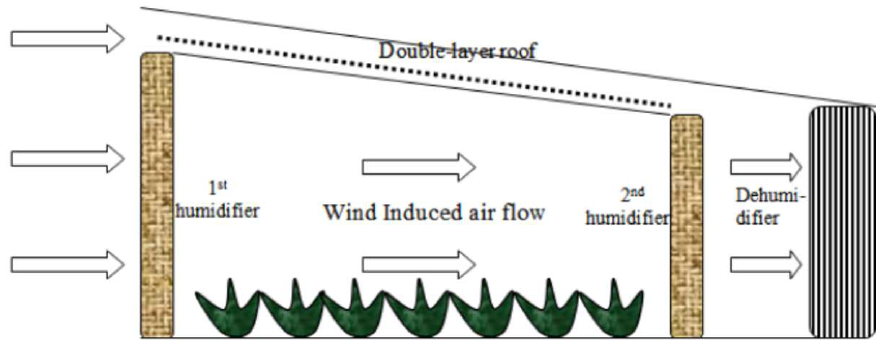
Figure 19. A sketch of combined solar still and a GH [332].